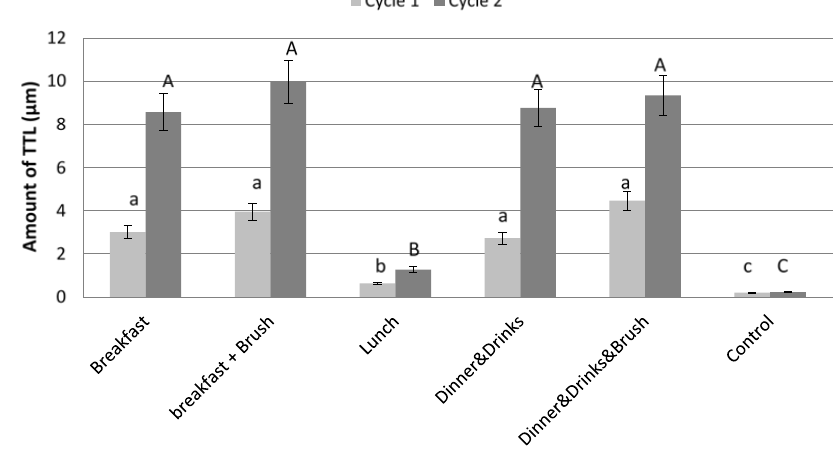
Figure 2. The amount of TTL caused by individual meals following one and two cycles. Error bars show standard deviation and the use of different letters signifies that groups are significantly different ( p < 0.05). Lower case letters are associated with cycle 1 and upper case letter are associated with cycle 2.